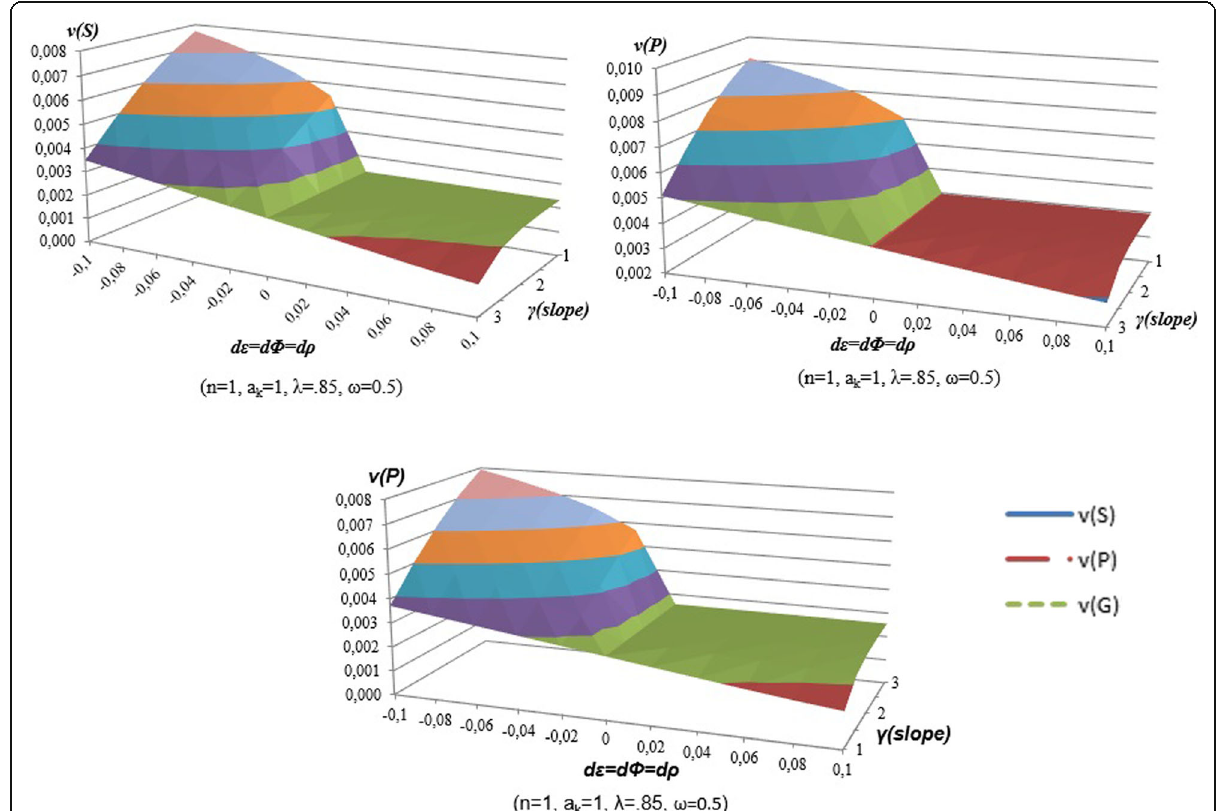
Fig. 4 Upper bounds of v(A S ), v(A P ) and v(A G ) for various slope ( γ ) and CSP performance tendency (d ε = d Φ = d)